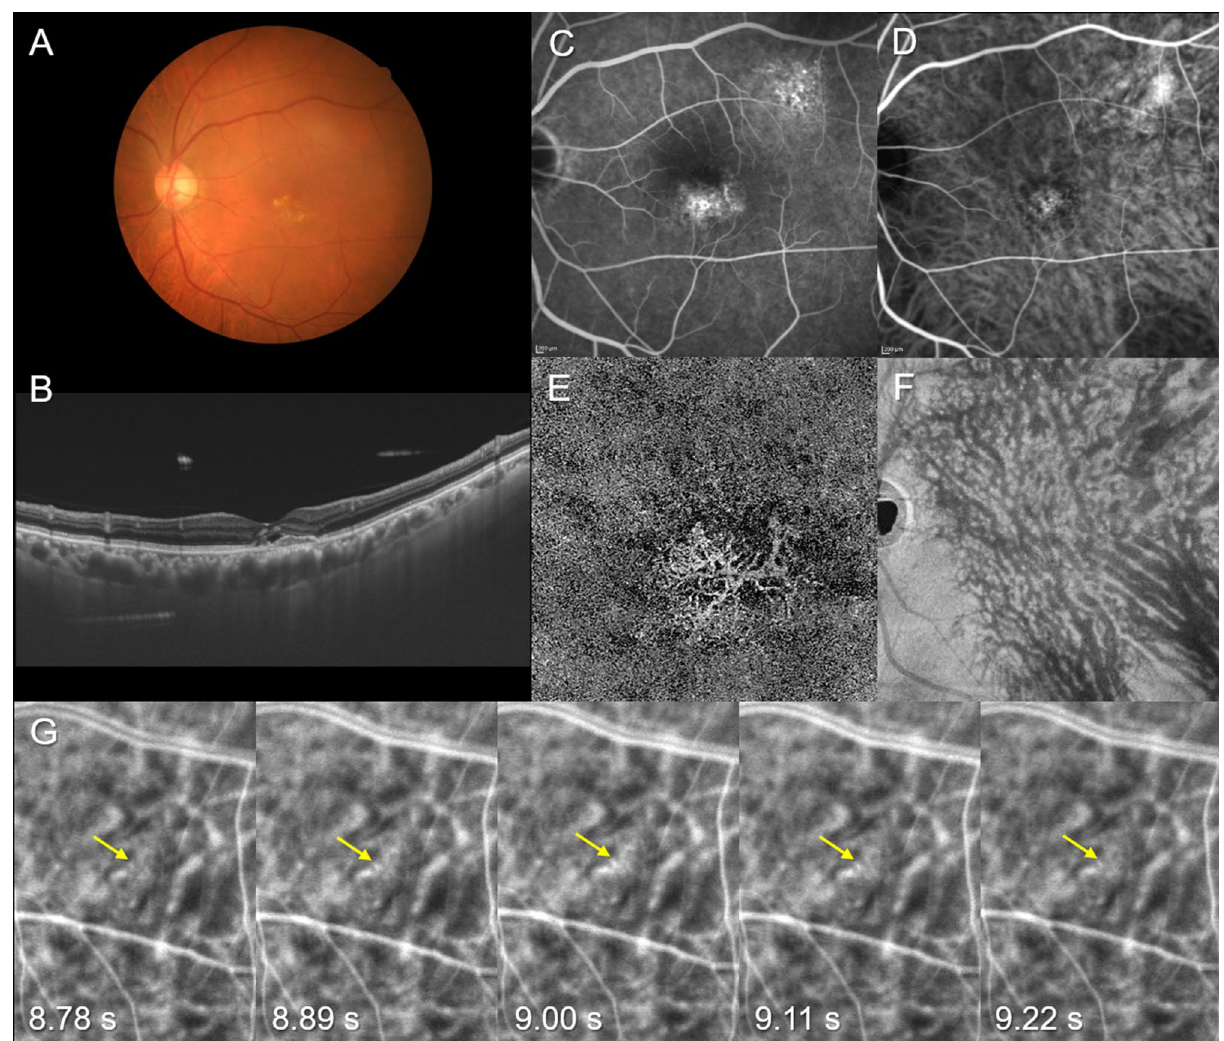
Figure 1. Images of the right eye of a 72-year-old man with pachychoroid neovasculopathy. The refraction was + 1.00 diopters. Best-corrected visual acuity was 0.30 logarithm of the minimum angle of resolution unit. ( A ) Color fundus photograph shows retinal pigment epithelium (RPE) abnormality at the macular area. ( B ) 12 mm vertical B-mode optical coherence tomography (OCT) images through the fovea show pachychoroid with dilated outer choroidal vessels (vortex veins). A shallow irregular RPE detachment accompanied by SRD is observed at the fovea. The central choroidal thickness is 302 µm. ( C ) Fluorescein angiography shows window defects and some leakage in the macular area as well as window defects superotemporal to the macular area. ( D ) Indocyanine green angiography (ICGA) shows dilated choroidal vessels and suspected choroidal neovascularization (CNV) at the macular area. ( E ) OCT angiography (3 mm x 3 mm) shows network vessels of CNV between the detached RPE and Bruch’s membrane. ( F ) En face OCT image shows dilated vortex veins in the deep layer of the choroid. The horizontal watershed is lost due to anastomoses between the superior and inferior vortex veins. ( G ) Early phase (8.78–9.22 s after choroidal filling) of ICGA in the superotemporal quadrant shows pulsatile flow in a vortex vein (yellow